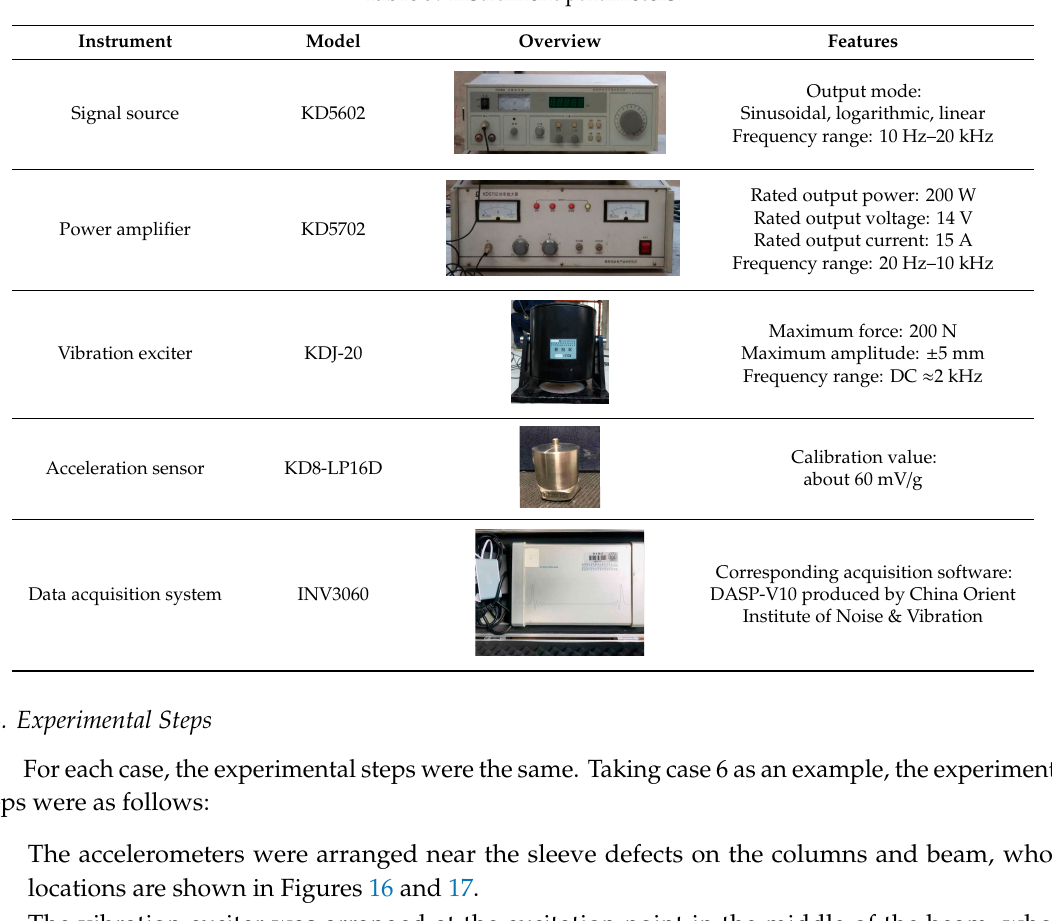
Table 9. Instrument parameters.